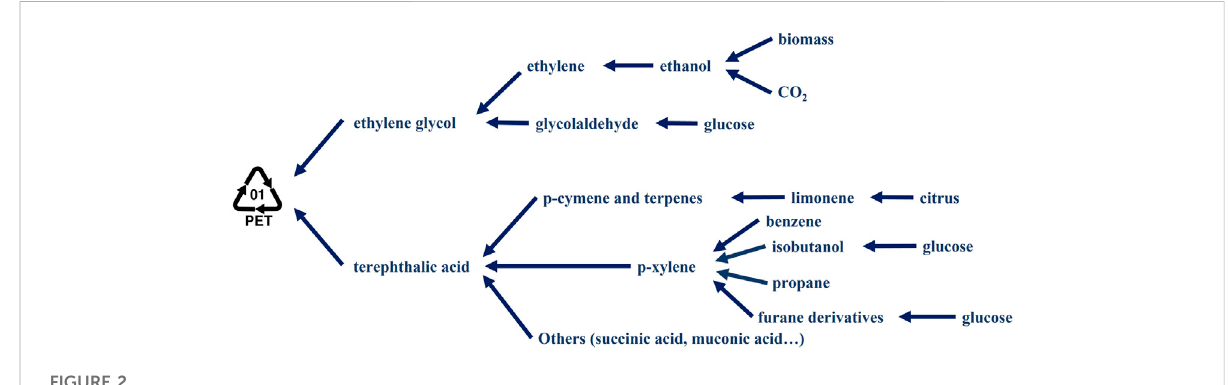
FIGURE 2 Alternatives routes for bio-based